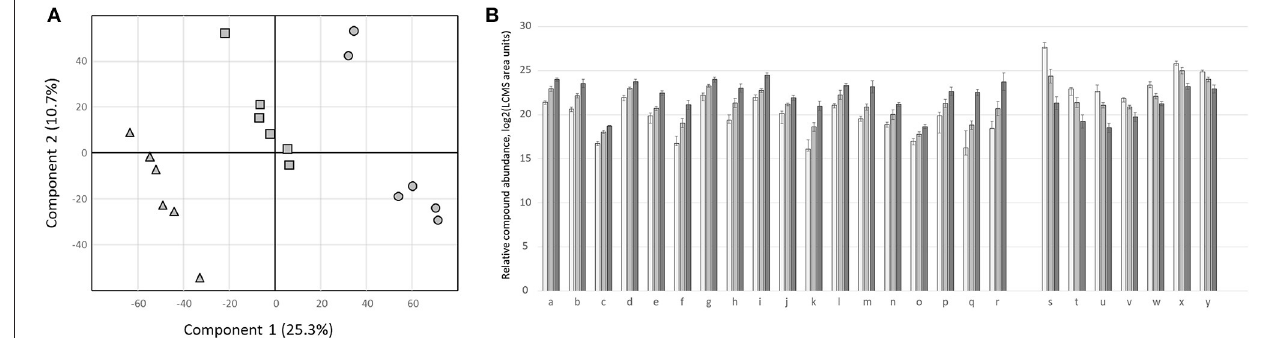
FIGURE 12 | Leaf metabolome changes of control plants during development. (A) Partial least squares discriminant analysis (PLS-DA) based on secondary metabolites in control treatments of strawberry leaves at different developmental stages. Triangles 9-week-old leaf metabolomes; squares, 15-week-old; circles 24-week-old. Cross-validation of the model: Q 2 = 0.9. (B) Relative abundance of metabolite features with highest variable in projection (VIP) score. White bars abundance in 9-week-old leaves; light-gray bars 15-week-old; dark-gray bars 24-week-old. Bars represent log 2 values of means ± SD N = 6. Letters indicate different compounds, for details see Supplementary Table 3